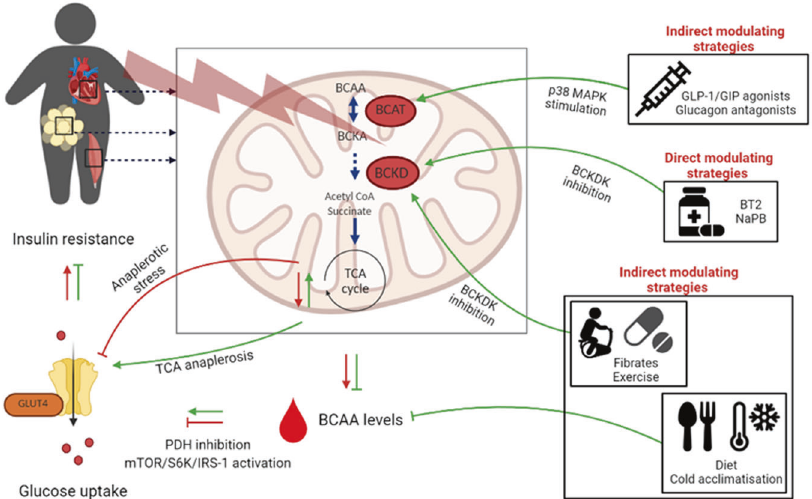
Fig. 3 Schematic overview of pharmaceutical and alternative strategies and their hypothesized way of action to boost BCAA oxidation and lower BCAA levels. BCAA branched-chain amino acids, mTOR mammalian target of rapamycin complex, S6K ribosomal S6 kinase, IRS-1 insulin receptor substrate-1, PDH pyruvate dehydrogenase complex, GLUT4 glucose transporter type 4, BT2 3,6-dichlorobenzo(b)thiopene-2- carboxylic acid, NaPB sodium phenylbutyrate, GLP-1 GCR-like peptide-1, GIP glucose-dependent insulinotropic